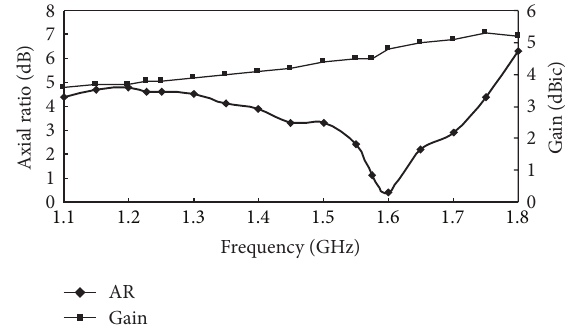
Figure 9: Simulated results of gain and axial ratio.